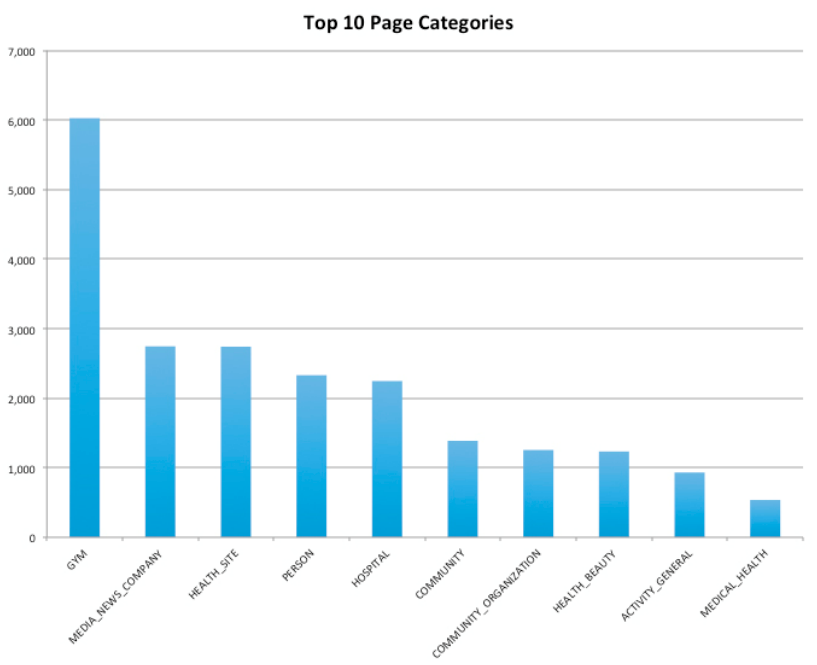
Figure 7. Top 10 page categories. Representation of top 12 page categories on Facebook pages and groups.